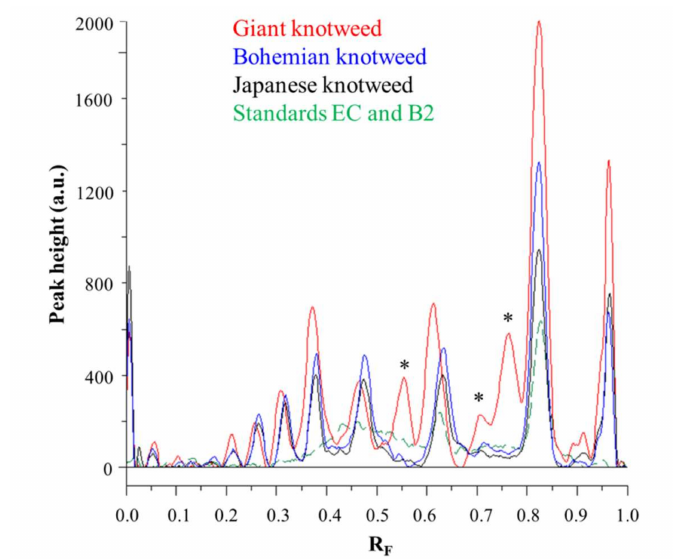
Figure 6. Comparison of videodensitogram fingerprint profiles of STSs (1 µ L, 50 mg / mL) from leaves of Japanese, Bohemian and giant knotweed with videodensitogram of standards ( − )-epicatechin ( EC ; R F = 0.82) and procyanidin B2 ( B2 ; R F = 0.63) (30 ng; dashed green line). Videodensitograms